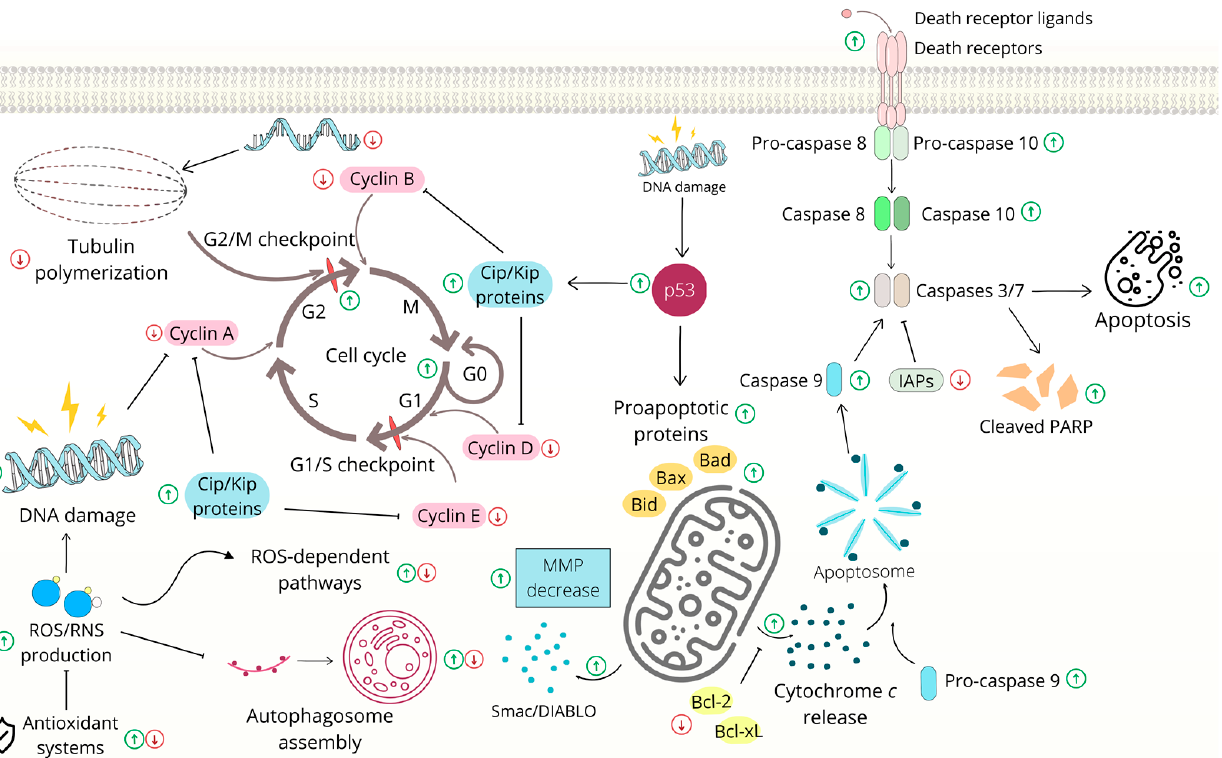
Figure 2. Cell cycle arrest and apoptosis induced by chalcones in gastrointestinal cancer cells. Ab- breviations: (pro)Casp—(pro)caspase, Bcl-2/Bcl-Xl—antiapoptotic proteins, Bad/Bax/Bid—